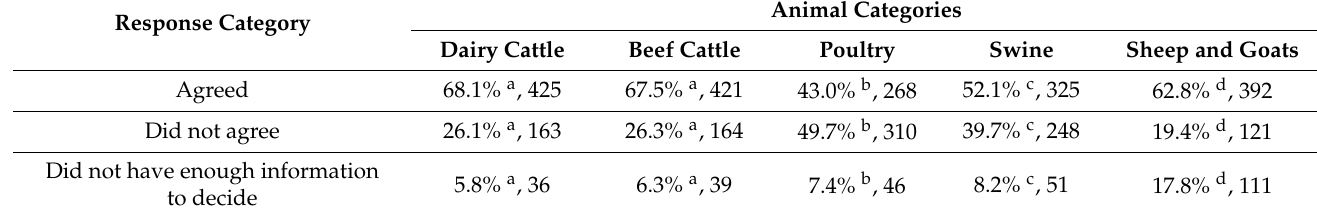
Table 3. The percentage of respondents for each level of agreement in response to the